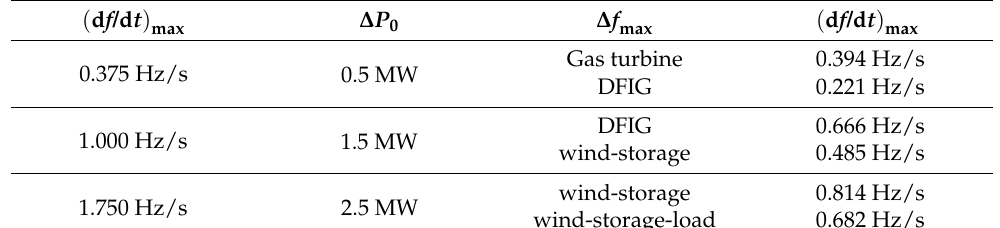
Table 2. System maximum frequency deviation prediction result.